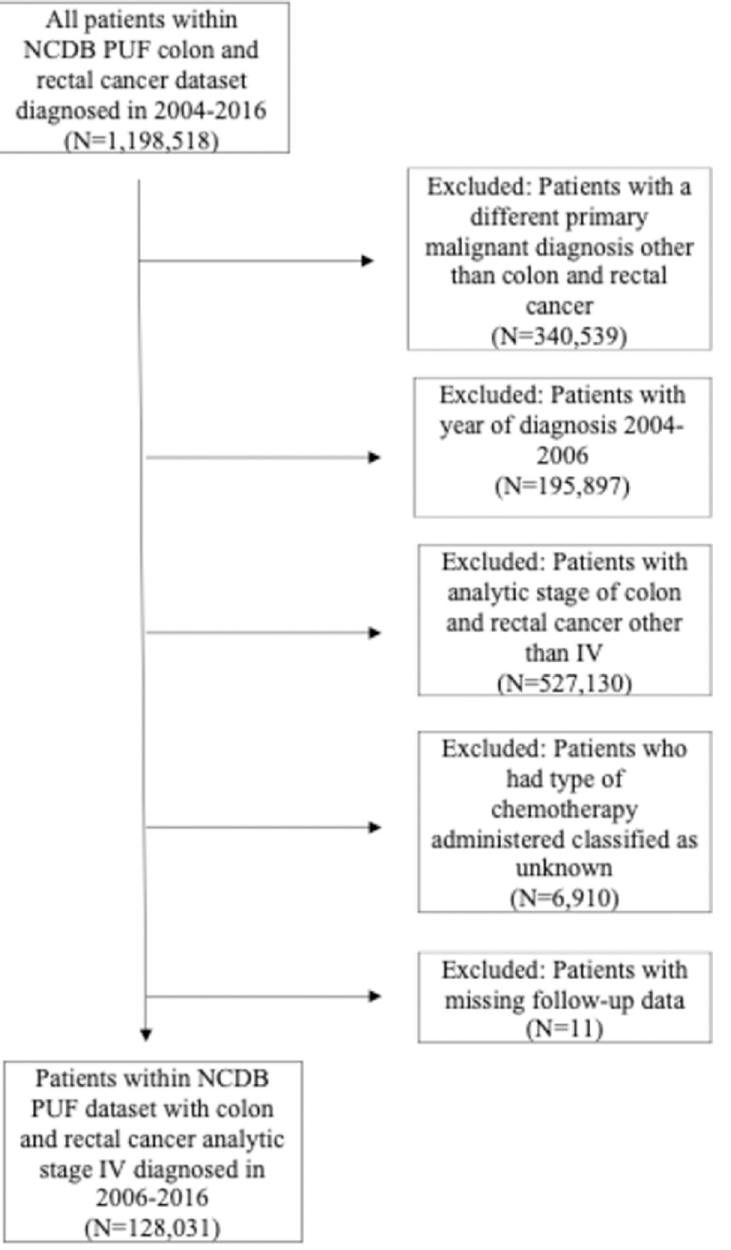
Fig 1. Flowchart diagram of the selection of cohort for